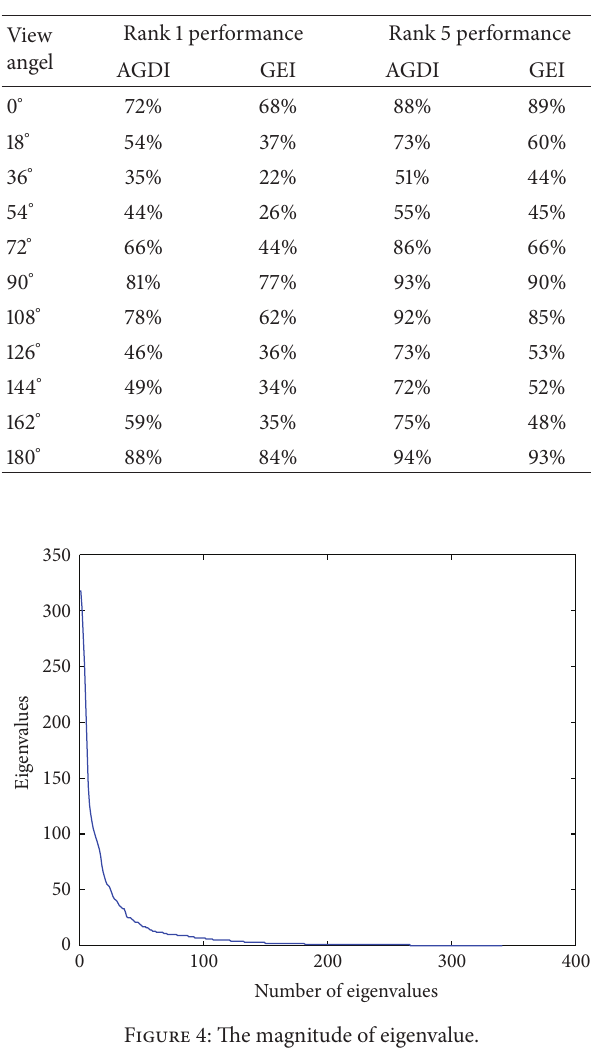
respectively. The data set view angel is 90 ∘ and every frame is resized to 120 × 160